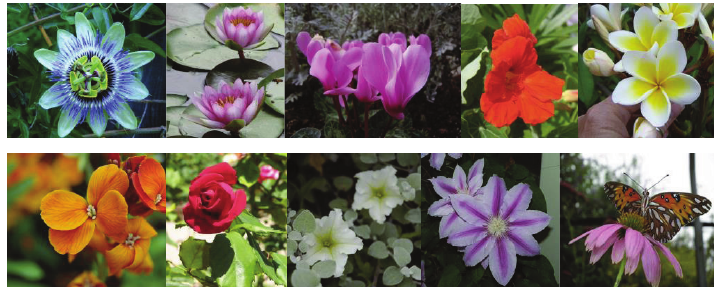
Figure 5. Example images from the Oxford 102 Flowers dataset. Table 6. The classification results (%) on the Oxford 102 Flowers dataset.